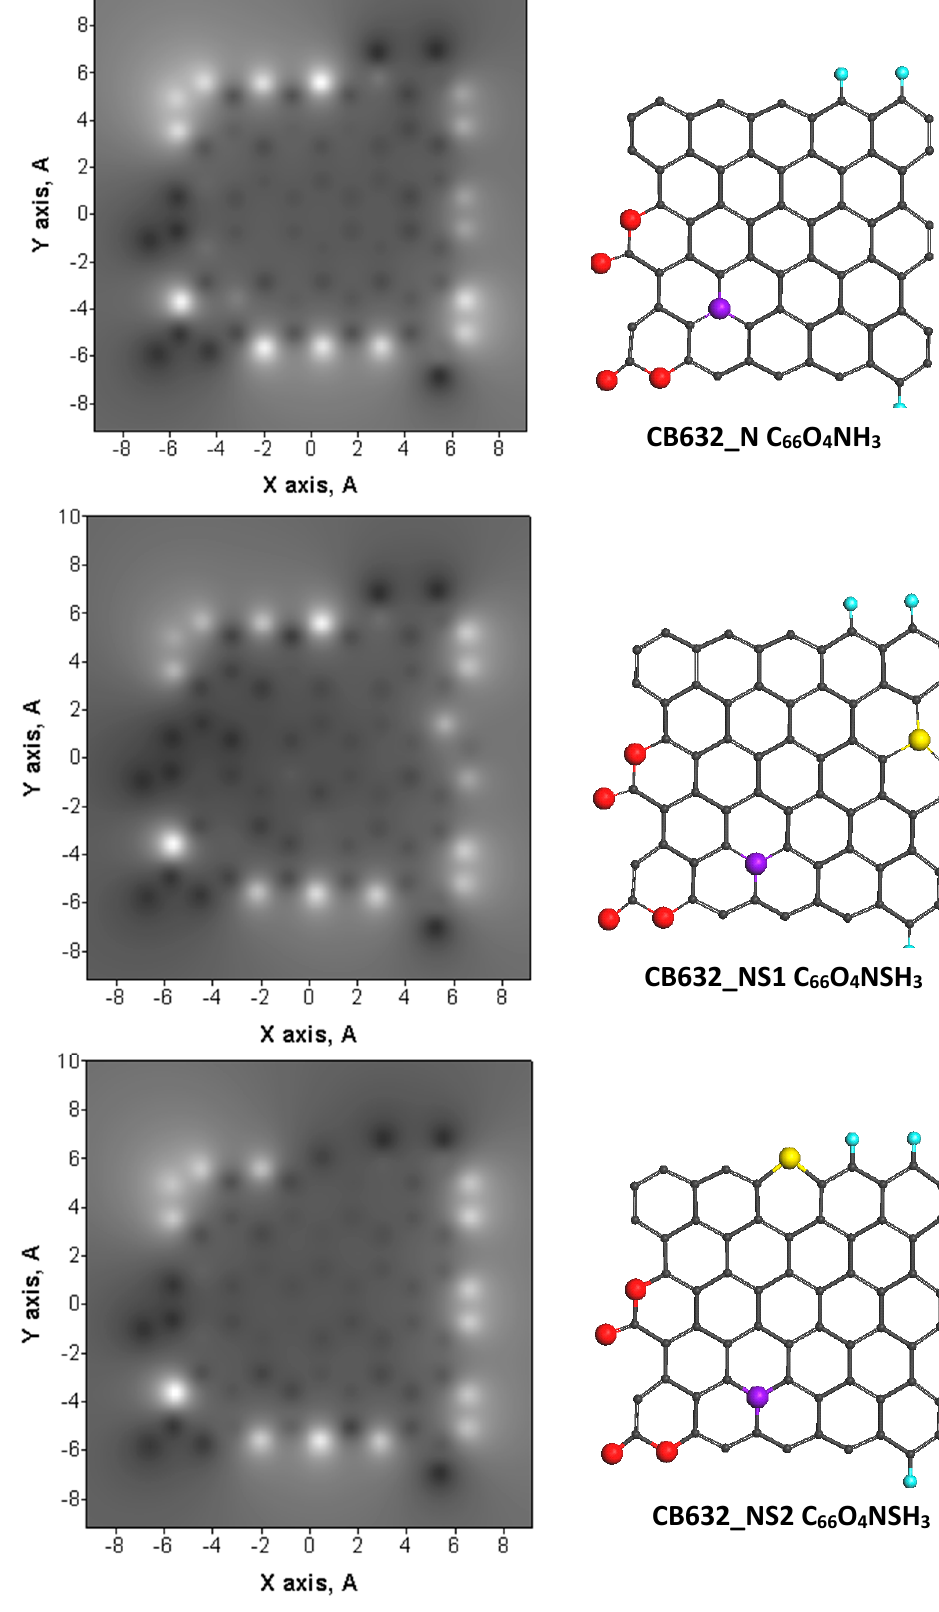
Figure 5. ACS N DA maps ( left ) and equilibrium atomic structures ( right ) of carbon black GONSH Figure 5. Figure 5. models decorated with single atoms of nitrogen (dark blue balls) and sulfur (yellow